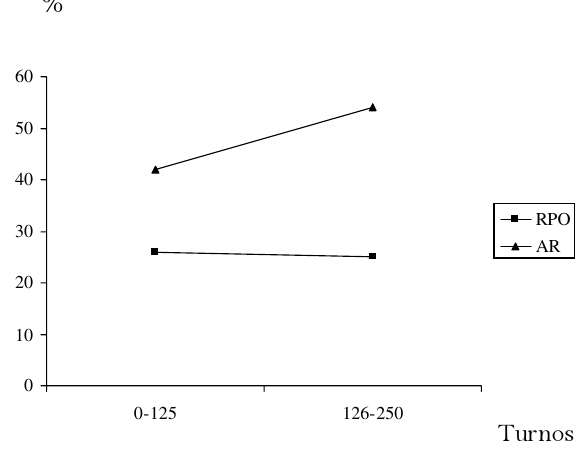
Figura 1. Percentual de movimentos reflexivos regulados por outro (RPO) e auto-regulados (AR) ao longo da